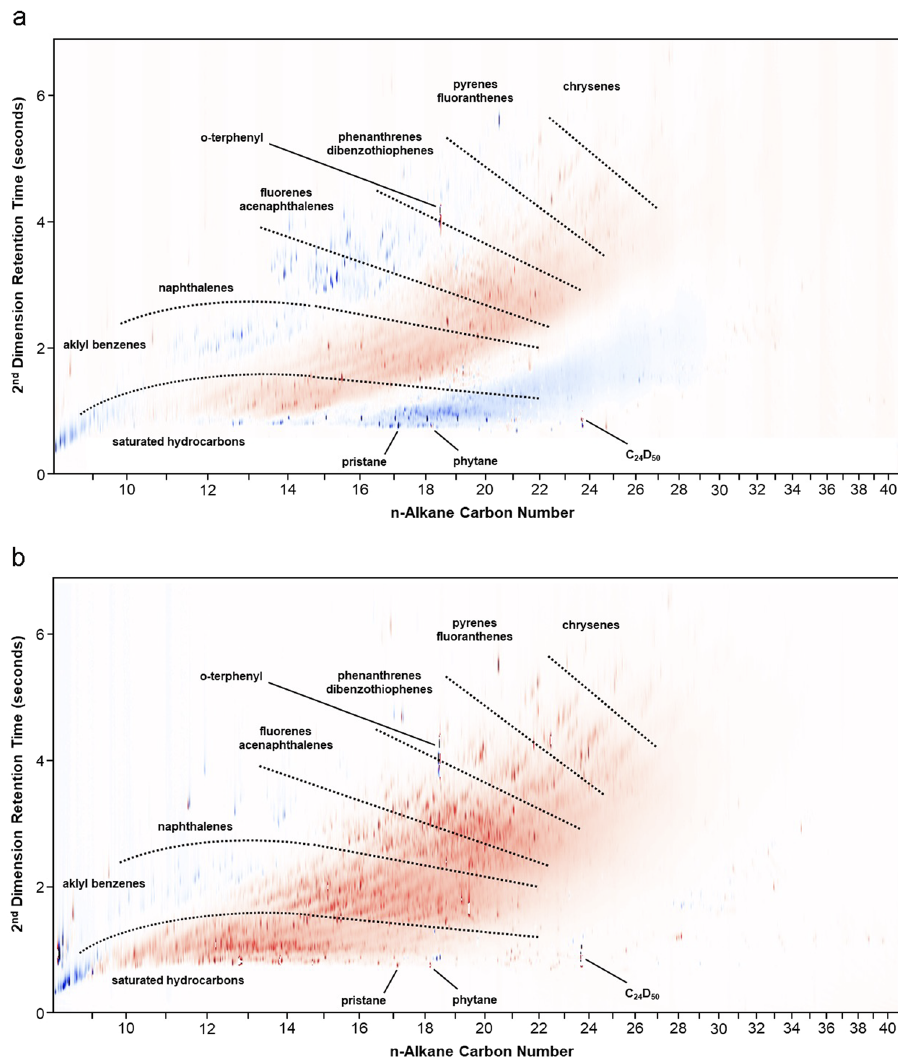
Fig. 4 Difference chromatograms for Guaymas Basin sediment cores. These chromatograms compare the presence and relative abundance of hydrocarbons in the core top compared to about mid-level in the core. The Cathedral Hill core 4991-7 ( a ) compares the 0 – 6 and 12 – 18 cm depth intervals. The Marker 14 core 4998-15 ( b ) hydrocarbons in the 0 – 7 and 14 – 21 cmbsf depth intervals. Compounds that remain at the same abundance throughout the core vanish in the subtraction chromatogram (cancelletion). Red peaks highlight compounds with positive values. In these chromatograms, lower core depth (12 – 18 and 14 – 21 cmbsf) intervals were subtracted from the 0 – 7 cmbsf interval. Red peaks represent hydrocarbons that are more abundant in the 0 – 7 cmbsf interval. Conversely, blue peaks represent negative values and indicate greater relative abundance in the deeper depth interval. In sum, red peaks indicate compounds present in higher abundance in the sur fi cial depth interval, and blue peaks are those more abundant down